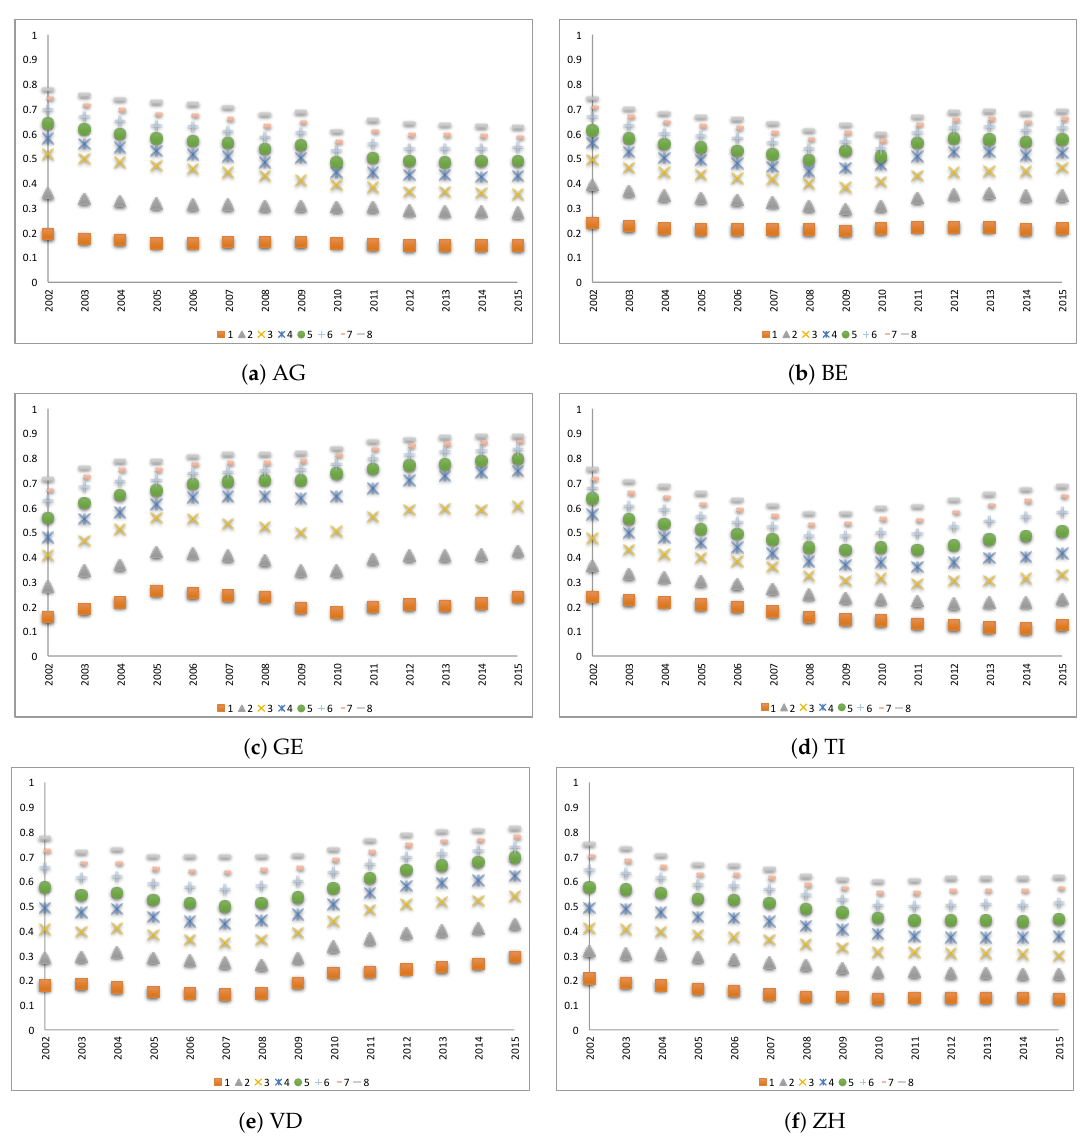
Figure 3. Market shares of eight largest insurers in different cantons